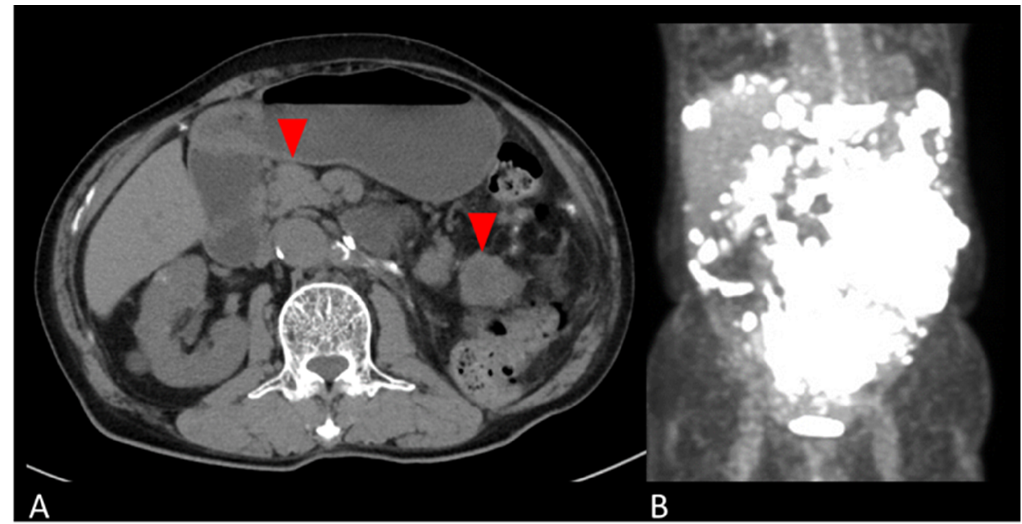
Figure 2. Abdominal images of peritoneal mass. ( A ) Axial CT and ( B ) coronal PET-CT images show multiple masses in the retroperitoneum (red arrows in A ).